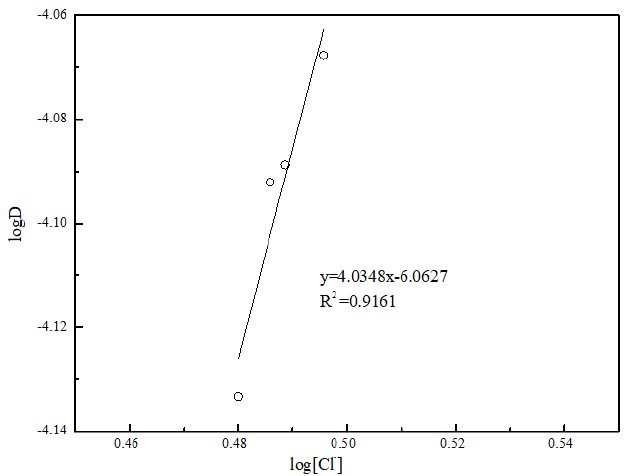
Figure 9. A plot of logD versus log[Cl − ] for the extraction of Cu with TOPO.